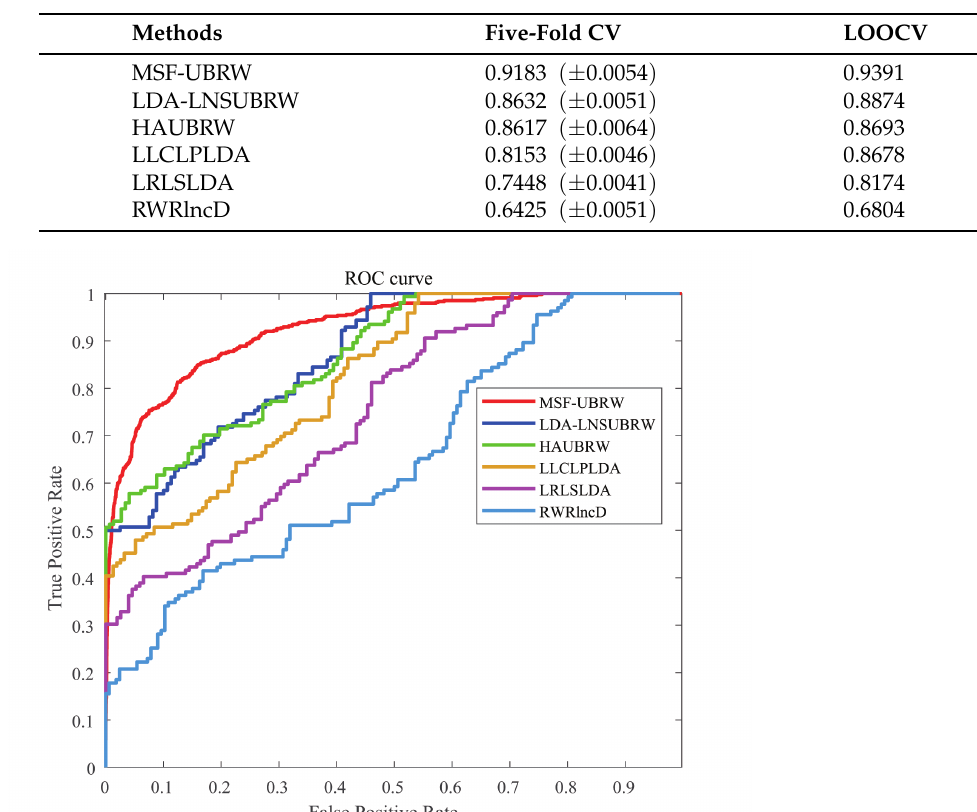
Table 1. Auc results of six methods.